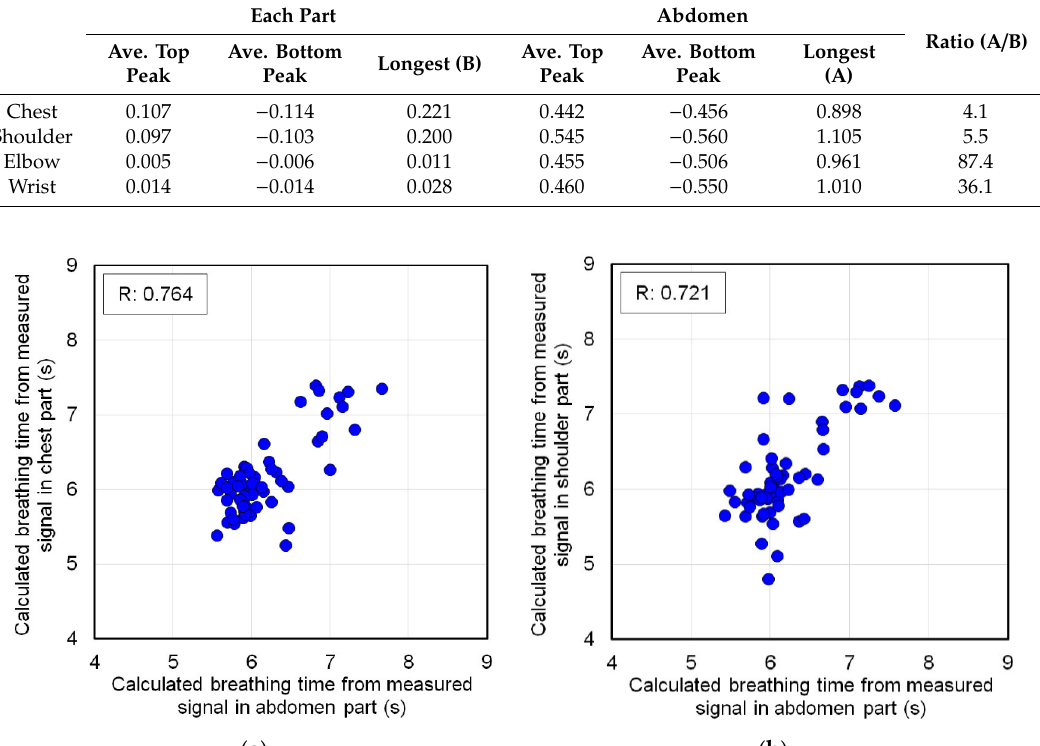
Figure 10. Scatterplot of breathing time from the signals measured at the chest and shoulder against the breathing time calculated from the abdominal signals. ( a ) Chest against abdomen, ( b ) Shoulder against abdomen.